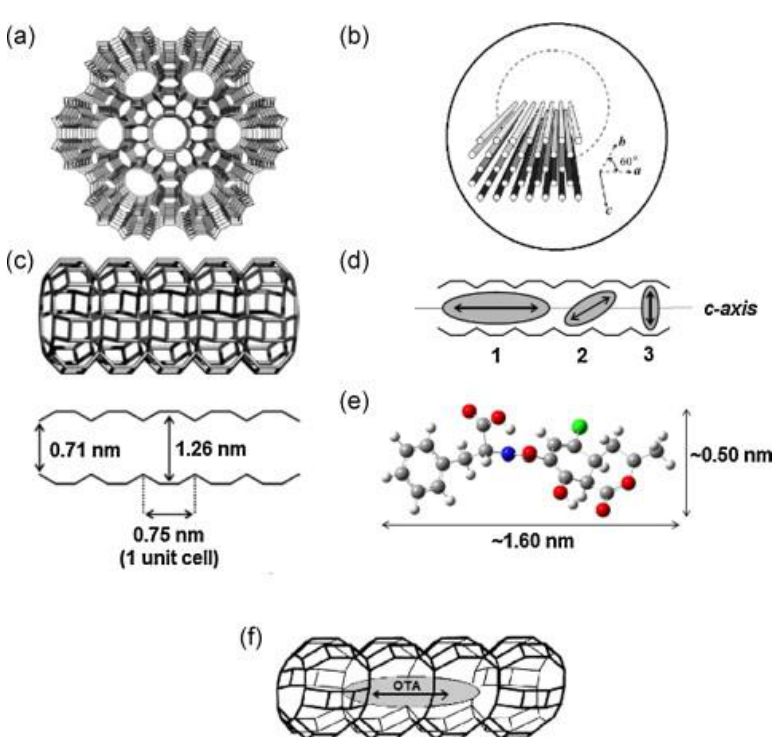
Figure 7. ( a ) Top view of the structure of zeolite Linde Type L (LTL) illustrating its hexagonal framework. It shows a channel surrounded by six neighboring channels. ( b ) Schematic view of some channels in a hexagonal zeolite LTL crystal with cylinder morphology. ( c ) Side view of a channel that consists of 0.75 nm long unit cells with a van der Waals opening of 0.71 nm at the smallest and 1.26 nm at the widest place. ( d ) Schematic illustration of di ff erent orientation of molecules in the main channel of LTL. ( e ) The width and length of ochratoxin A. ( f ) Schematic illustration of ochratoxin A in the main channel of LTL (reprinted with permission from reference [76]).